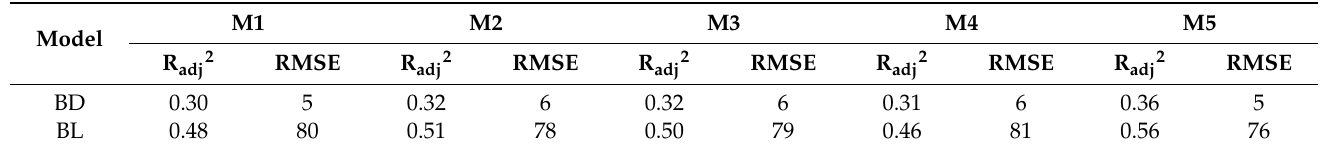
Table 4. The mean values of R adj2 and RMSE for the five equations used for modeling branch diameter and branch length of the Korean pine plantation using the leave-one-out